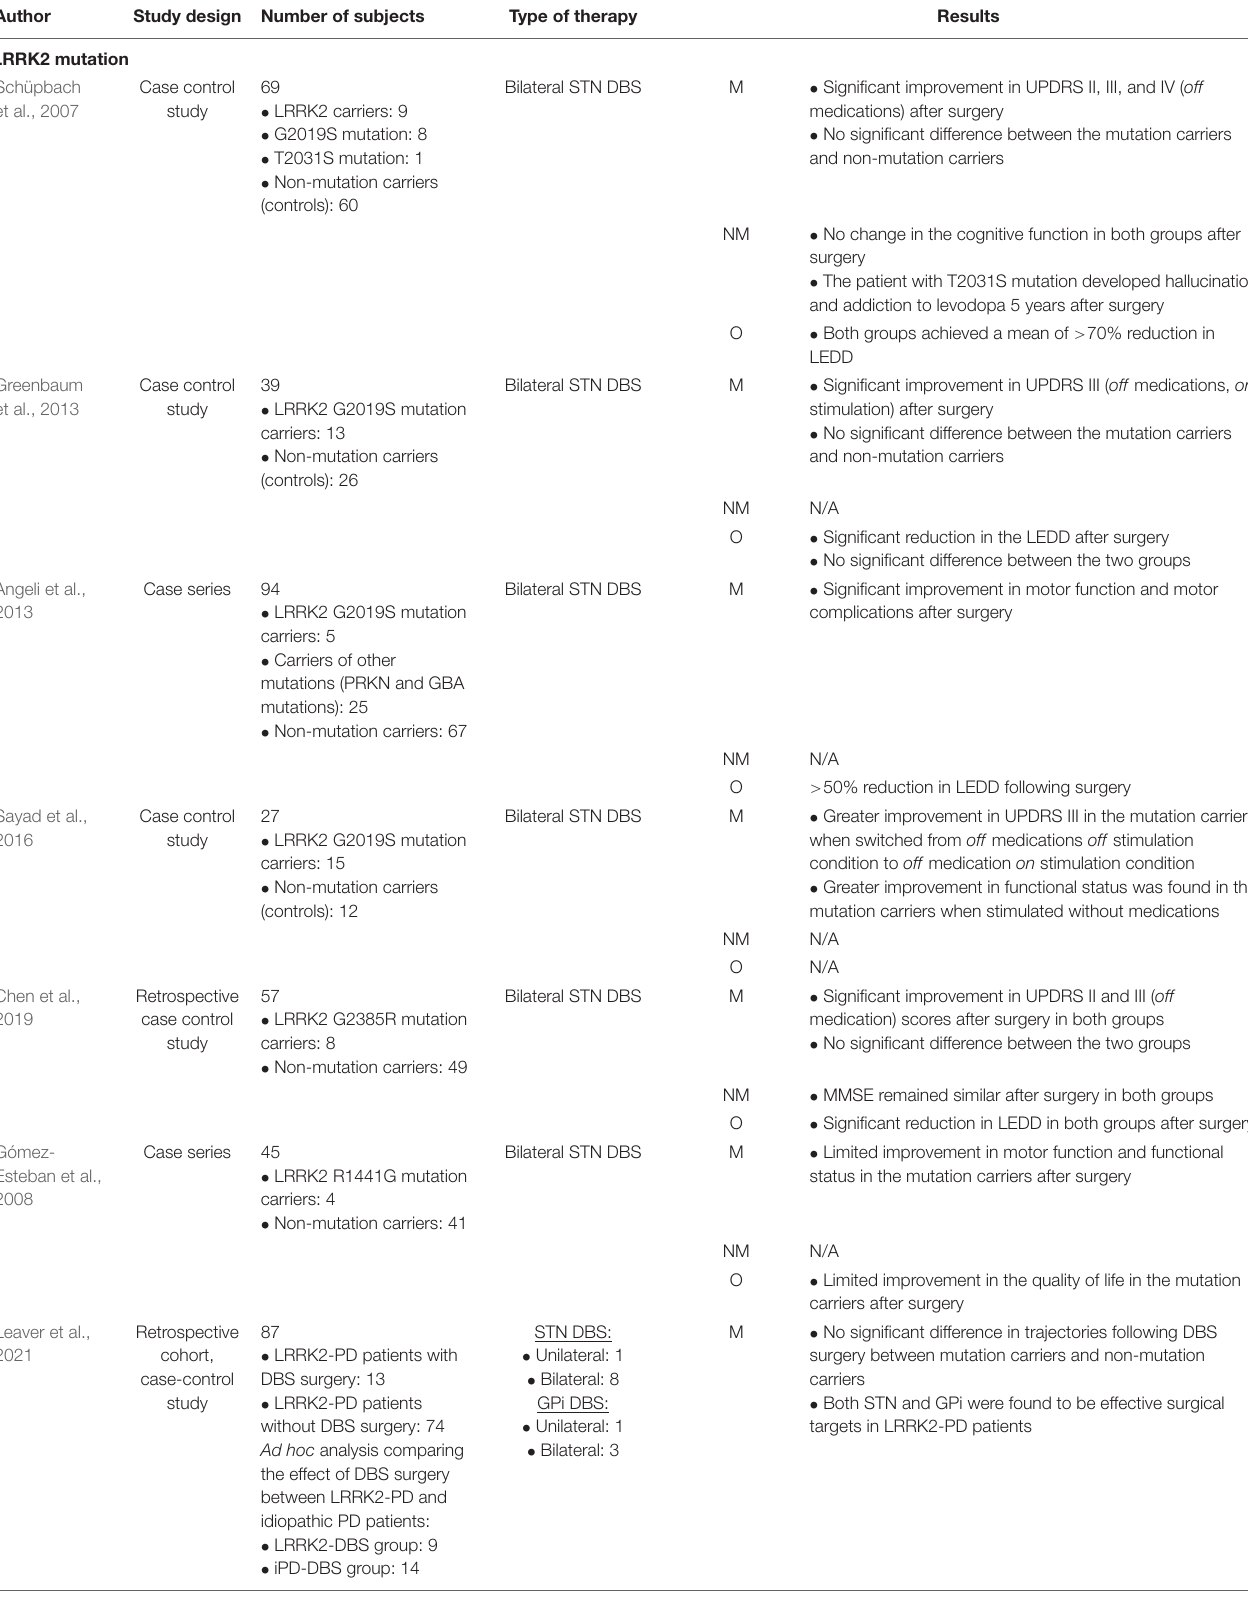
TABLE 2 | Summary of treatment outcomes of device-aided therapies in patients with monogenic